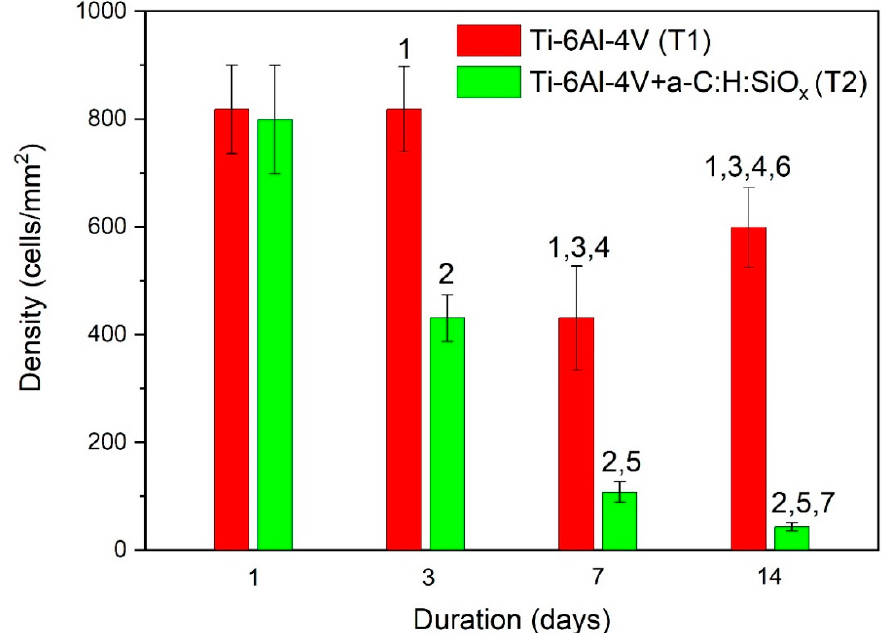
Figure 6. Density distribution of EA.hy926 cells depending on days of substrate cultivation: 1—T1 vs. T2 after 3, 7, and 14 days ( p < 0.02), 2—T1 vs. T2 after 1 day ( p = 0.01), 3—T2 vs. T1 after 1 day ( p = 0.01), 4—T2 vs. T1 substrate after 3 days ( p < 0.02), 5—T1 vs. T2 substrate after 3 days ( p = 0.01), 6—T2 vs. T1 substrate after 7 days ( p < 0.05), 7—T1 vs. T2 substrate after 7 days ( p = 0.01). Data are presented as mean ± SD. Each group consists of six substrates for testing.